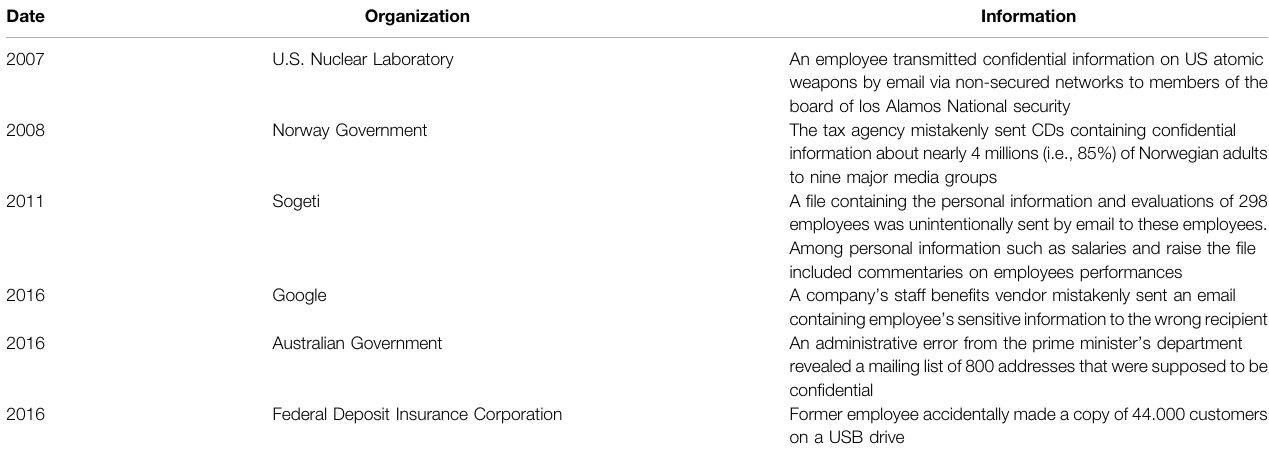
TABLE 1 | Some example of real cases of data